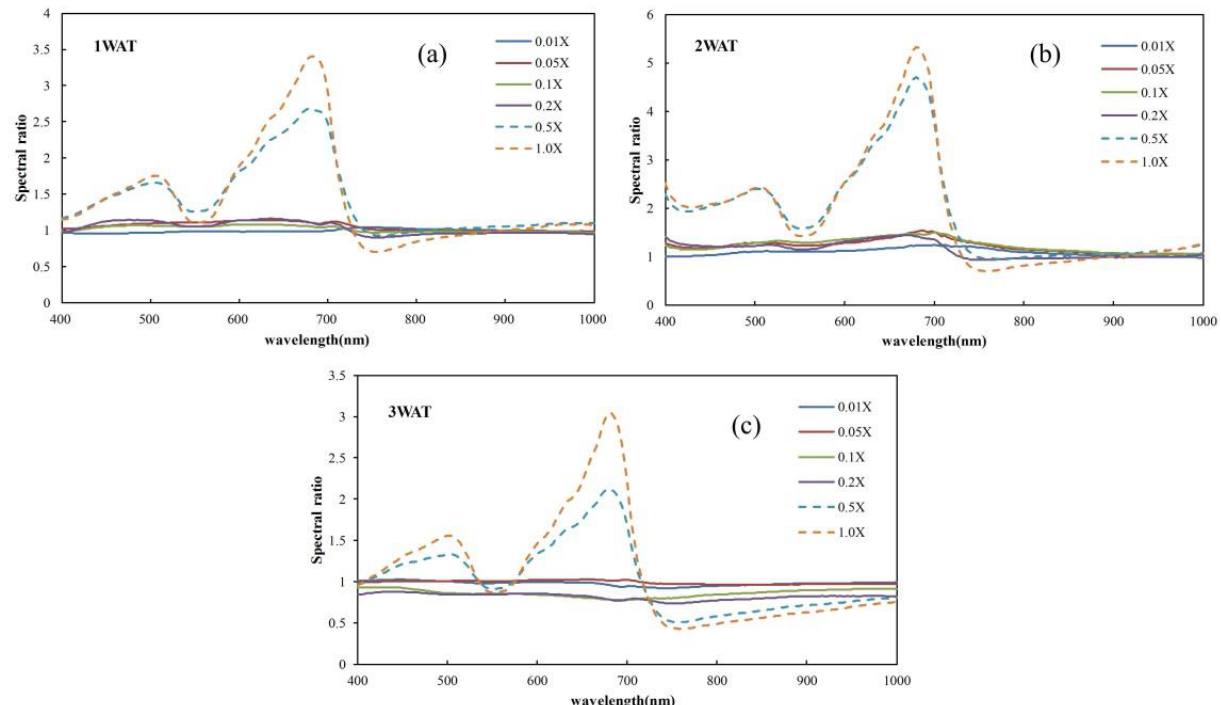
Figure 3. Average spectral ratio curves of corn plants at 1 week after treatment (WAT) ( a ), 2 WAT ( b ), and 3 WAT ( c ) under different glyphosate rates, where X = 0.866 kilograms acid equivalents/hectare (kg ae/ha) is the recommended application amount per hectare.